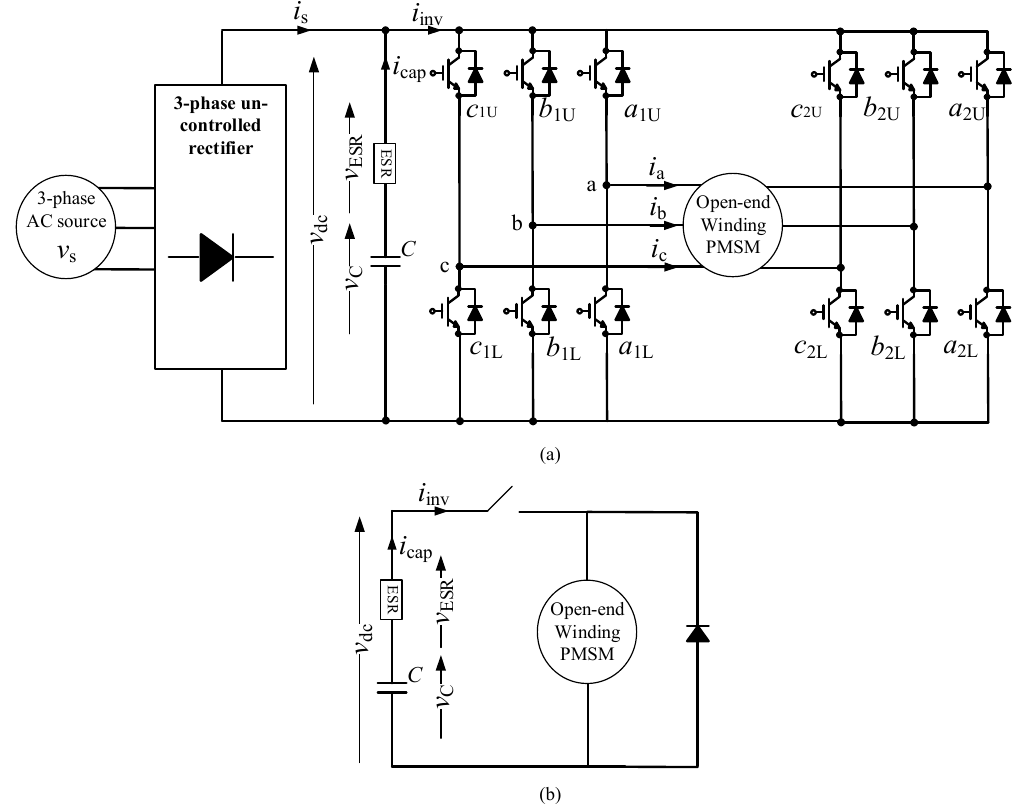
Figure 11. Circuit diagram of the permanent magnet synchronous machine (PMSM): ( a ) circuit diagram; ( b ) equivalent circuit during the discharge period when the machine stops.